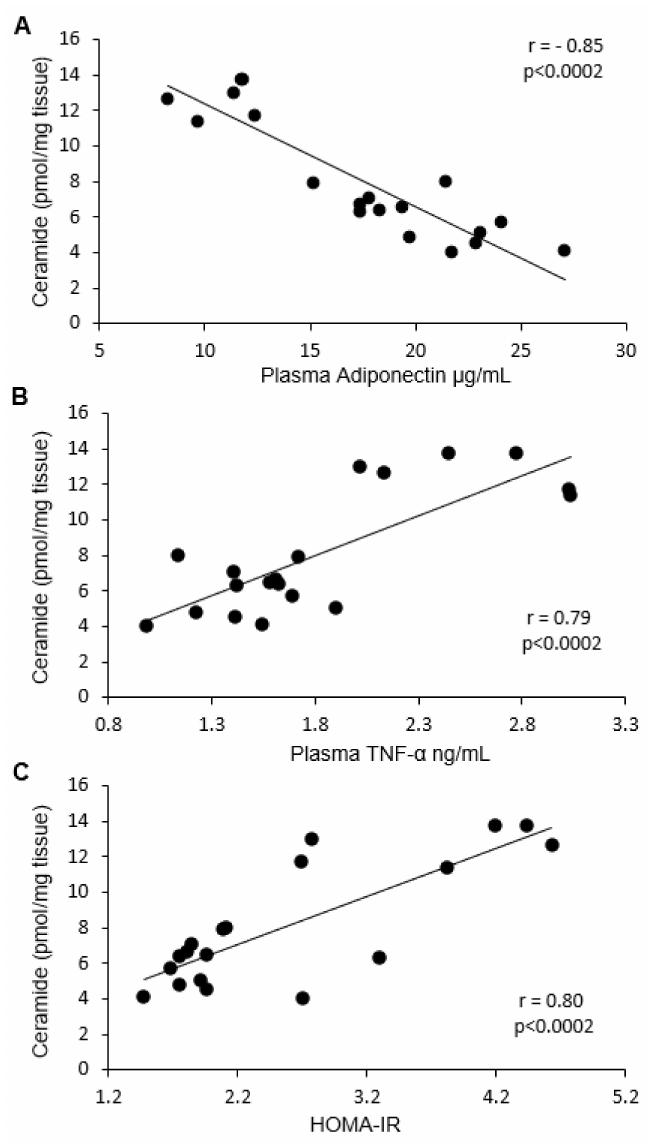
Figure 5. Panel ( A ) shows the correlation between ceramide content in subcutaneous fat tissue and plasma adiponectin concentration. Panel ( B ) shows the correlation between ceramide content in subcutaneous fat tissue and plasma TNF- α concentration. Panel ( C ) shows the correlation between ceramide content in subcutaneous fat and HOMA-IR